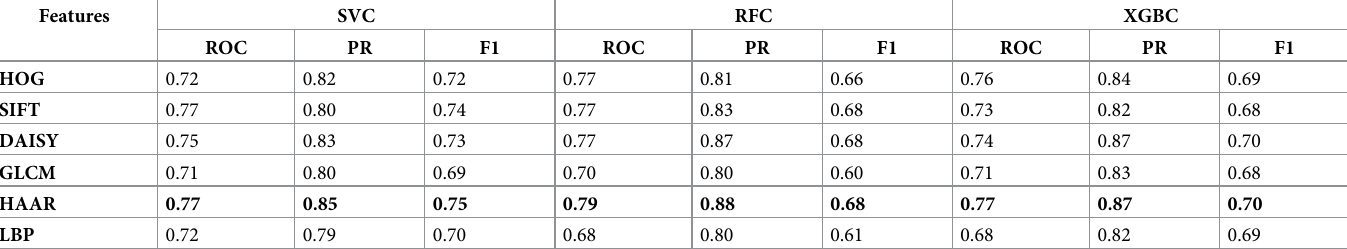
Table 2. Predictive performance for earthworm species prediction across different classification models and handcrafted features on external validation dataset ( E. fetida vs others).